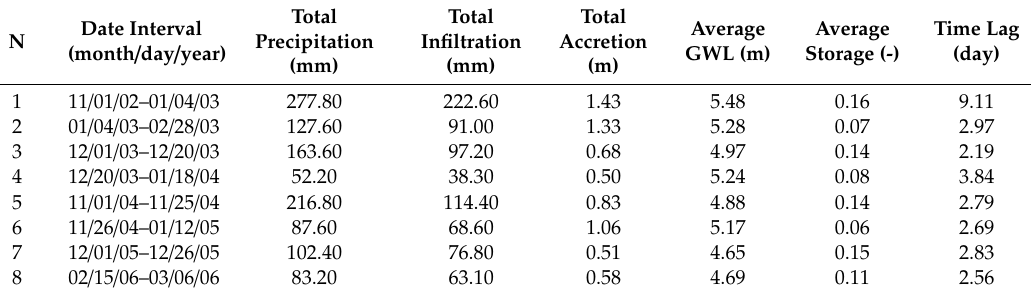
Table 1. Analysis of significant episodic rainfall